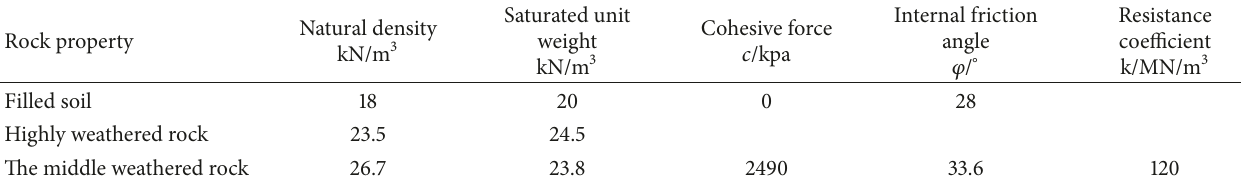
Table 1: The design